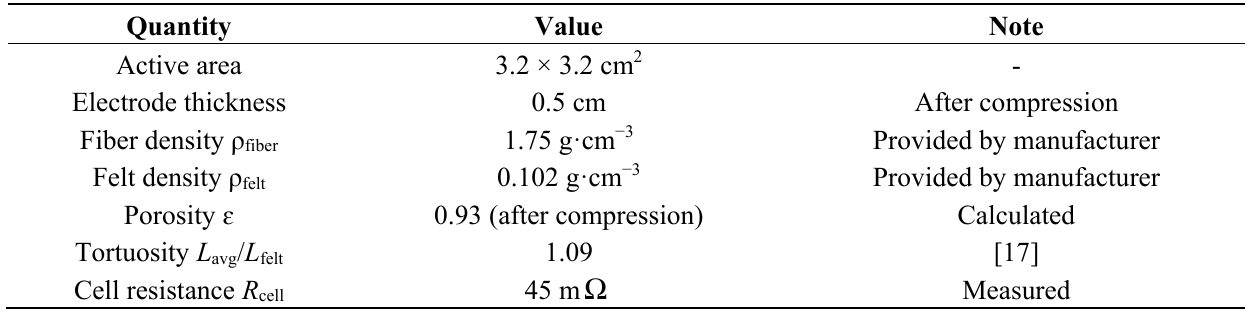
Table 1. Geometrical and physical parameters of the VRFB